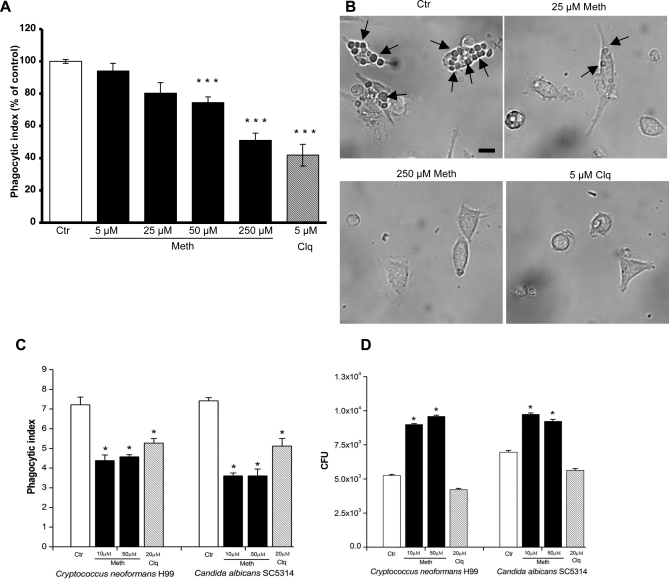
Meth and Clq Inhibit Phagocytosis in Mouse Peritoneal Macrophages(A) Cells were incubated in indicated concentrations of Meth or Clq for 2 h, and then IgG coated erythrocytes were added. Extracellular uningested EIgG were lysed and removed. Phagocytic index (PI) was quantified and inhibition is indicated as percent of control. Data were collected from four to seven experiments (n = 300 cells, mean ± SEM, ***p < 0.0001, two-tailed ANOVA).(B) Images of macrophage cells impaired in the phagocytosis of opsinized sheep erythrocytes after 2 h of Meth or Clq treatment. Arrows denote phagocytosed erythrocytes. Scale bar, 10 μm.(C, D) J774.16 cells were exposed to PBS, chloroquine, or methamphetamine for 2 h followed by incubation with Cn or Ca. The phagocytic indices (ratio of intracellular yeast to the number of macrophages counted) were determined after 1 h or 30 min for Cn and Ca, respectively (C). (Statistics n = 300, mean ± SEM, *p < 0.05, two-tailed ANOVA.) CFU determinations were preformed after 24 h incubations (D). The values are the mean and standard deviation from determinations made in triplicate wells (n = 300 cells, mean ± SEM, *p < 0.05, two-tailed ANOVA.). Experiments were repeated three times with similar results.